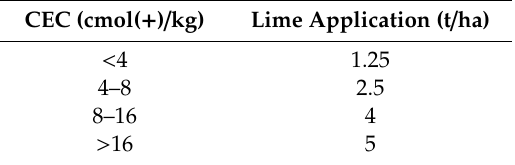
Table 2. Liming application guidelines for sugarcane in Thailand when pH less than 5.0 [29]. CEC (cmol( + ) / kg) Lime Application (t / ha) <